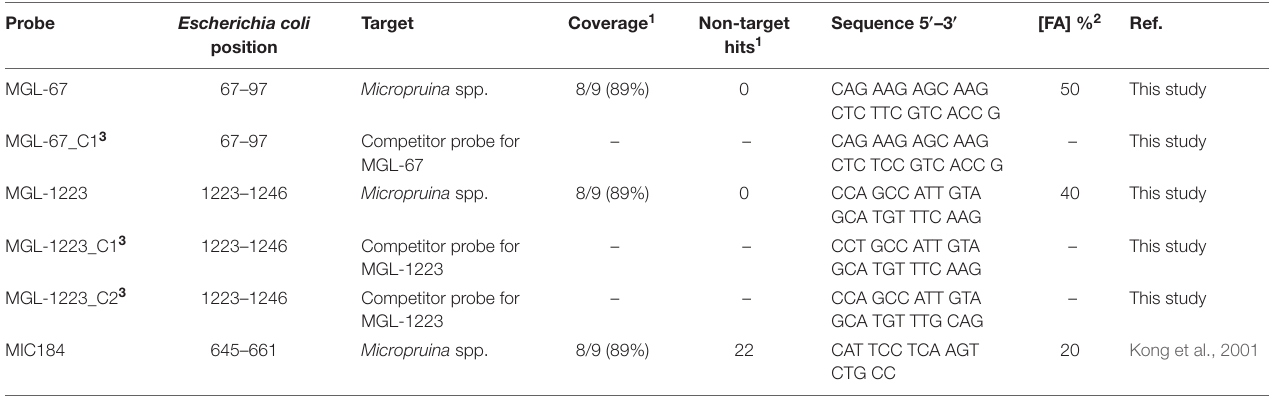
TABLE 1 | FISH probes designed for the detection of members of the genus